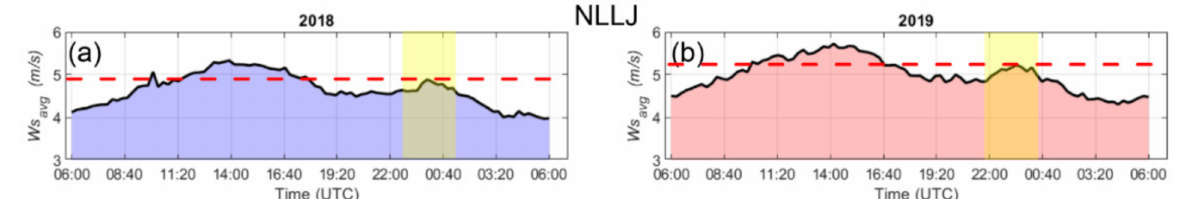
Figure 10. Time average of wind speed for all NLLJ days in 2018 ( a ); 2019 ( b ).